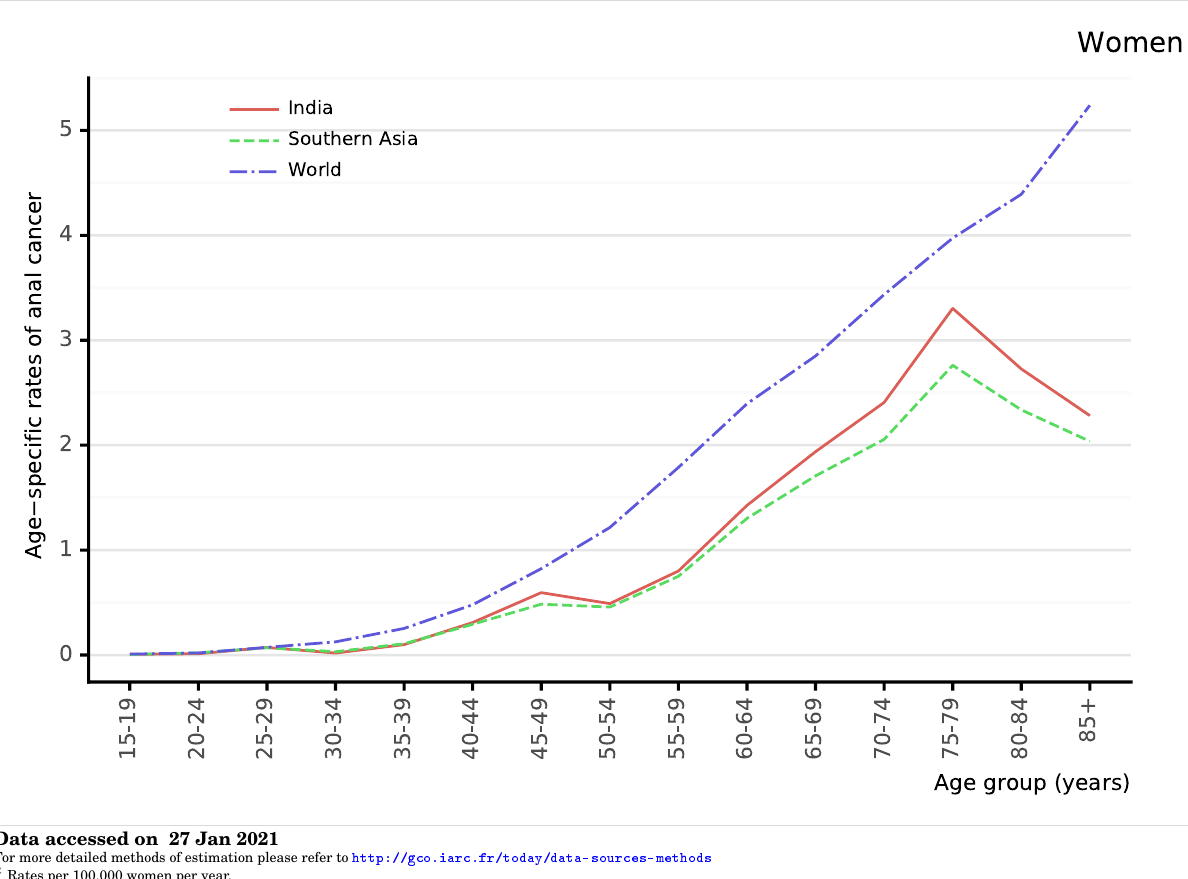
Figure 80: Comparison of age-specific anal cancer incidence rates among women by age in India, within the region, and the rest of